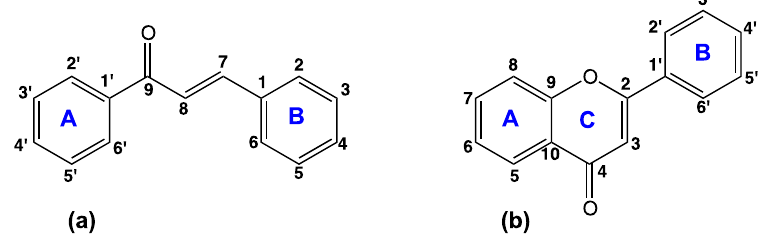
Figure 1. Basic structure and B ring position of chalcone ( a ) and flavone ( b ) molecules.